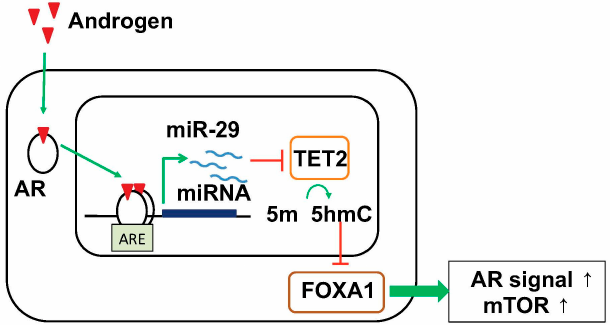
Figure 3. Model of TET2 repression by androgen-induced miR-29 to control the genome-wide 5-hydroxymethylated cytosine (5-hmC) status for prostate cancer progression. miR-29 represses TET2, causing reduction of 5-hmC and subsequent reduction of FOXA1 binding to specific binding sites, consequently activating pathways related to prostate cancer progression such as AR signaling and mTOR pathways. AR, androgen receptor; 5-hmC, 5-hydroxymethylated cytosine; 5-mC, 5-methylated cytosine; ARE, androgen responsive element.